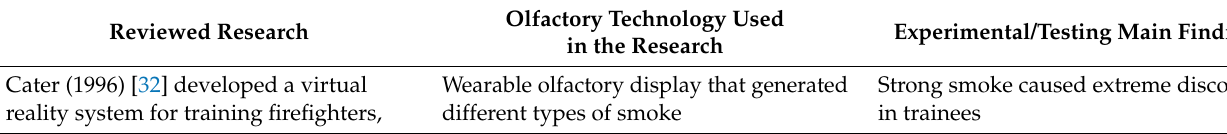
Table 2. A summary of research conducted on olfactory interfaces that support